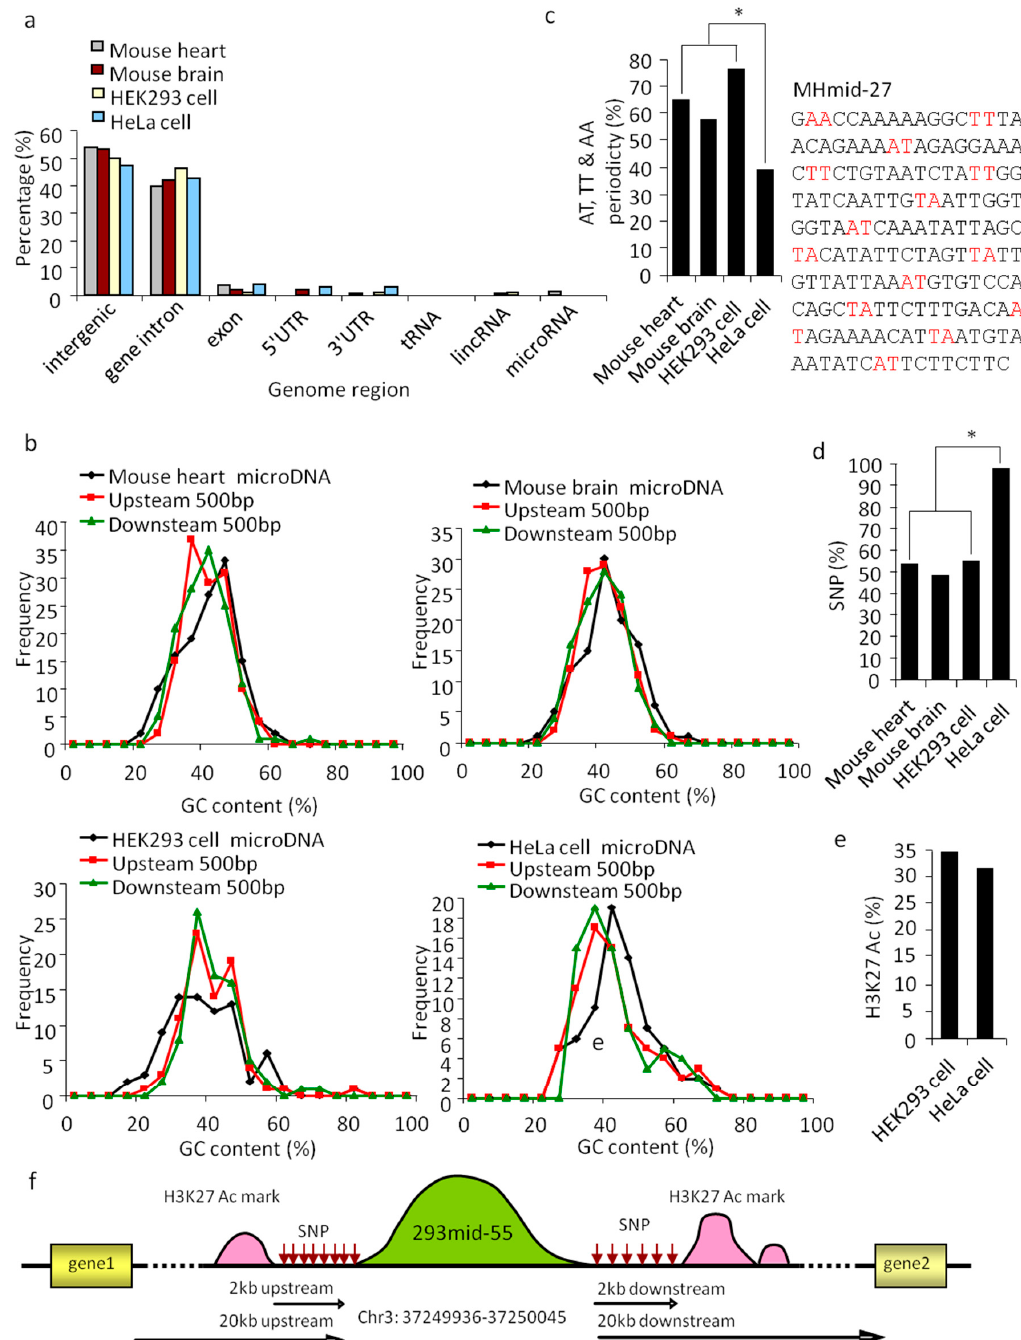
Figure 3. Properties of SSLmicroDNA sequences and their genomic loci. ( a ) Genome mapping of SSLmicroDNAs from mouse hearts, mouse brains, HEK293 cells and HeLa cells. ( b ) GC content of SSLmicroDNAs and their 500 bp-upstream and 500 bp-downstream regions. ( c ) Analysis of AT, TT or AA periodicity of SSLmicroDNA sequences from mouse hearts, mouse brains, HEK293 cells and HeLa cells. The MHmid-27 sequence periodically separated by AT, TT or AA is presented. * p < 0.05. ( d ) Analysis of single nucleotide polymorphism sites (SNPs). The data are the percentages of microDNA loci with SNPs within 2kb upstream or downstream. * p < 0.05. ( e ) Analysis of H3K27 Ac marks within 2 kb-upstream or -downstream regions of SSLmicroDNAs genomic loci. The data are the percentages of microDNA loci that have H3K27 Ac marks within the indicated regions. ( f ) A glance at the scenery near 293mid-55 in the genome.